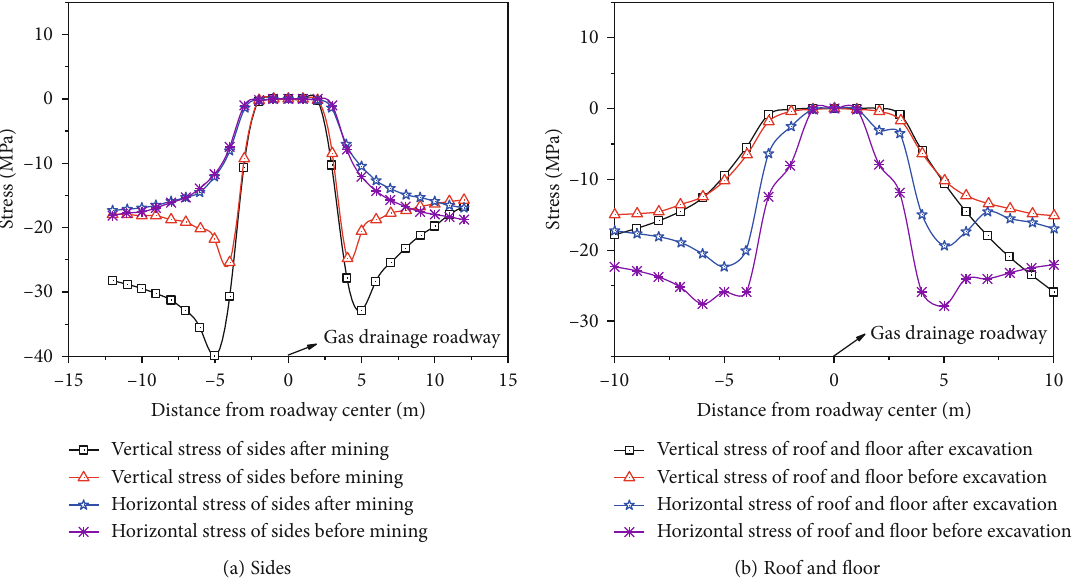
Figure 14: Stress distribution curve of roadway surrounding rock after